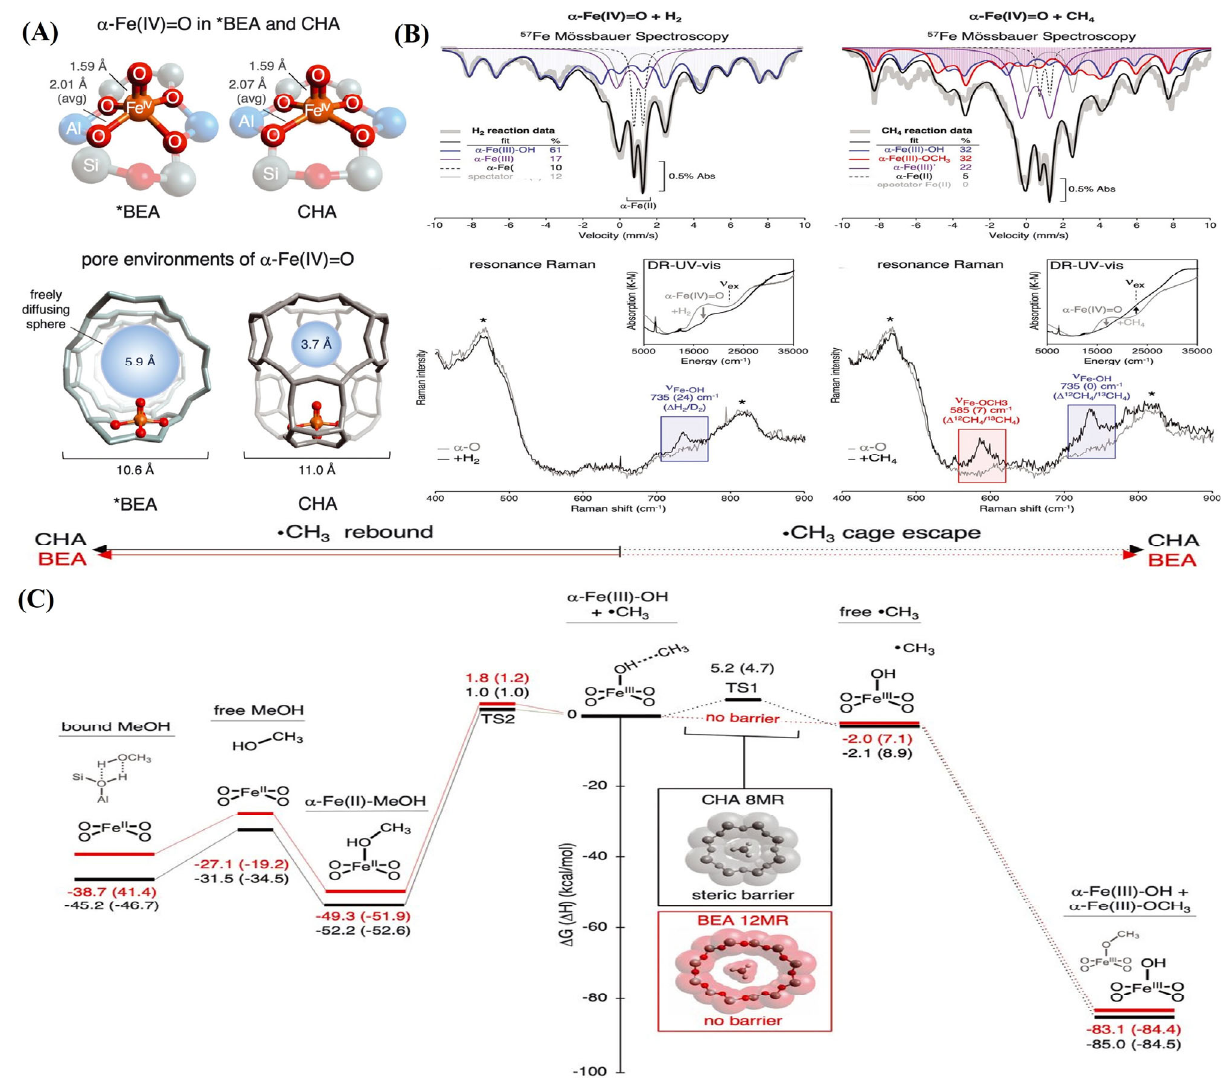
Figure 2. ( A ) ALocal environments of α ‐ Fe(IV)=O sites in *BEA and CHA; ( B ) identification of Fe(III) species after H 2 and CH 4 reactions with Fe − *BEA; and ( C ) comparison of reaction coordinates for * BEA (red) and CHA (black) after H-atom abstraction. Reprinted/adapted with permission